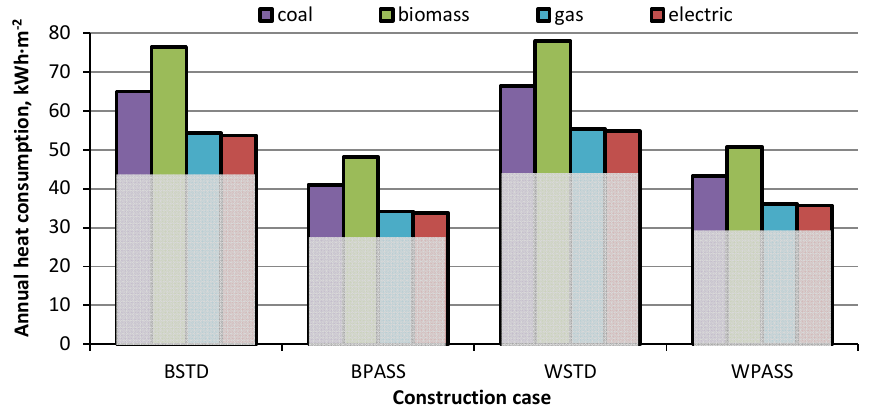
Figure 7. Annual heating consumption (final energy); heating demand (useable energy part) is indicated in grey.